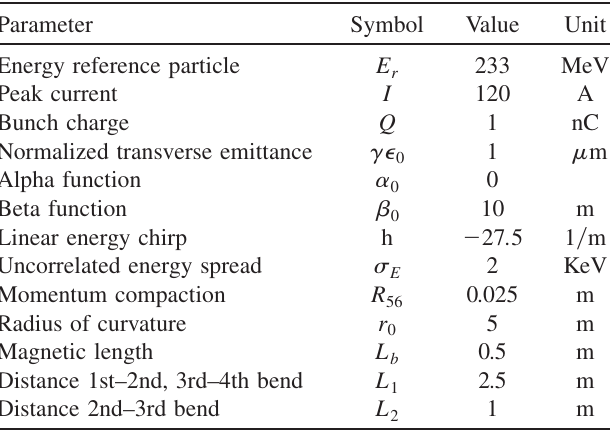
TABLE IV. Chicane parameters and beam parameters at first